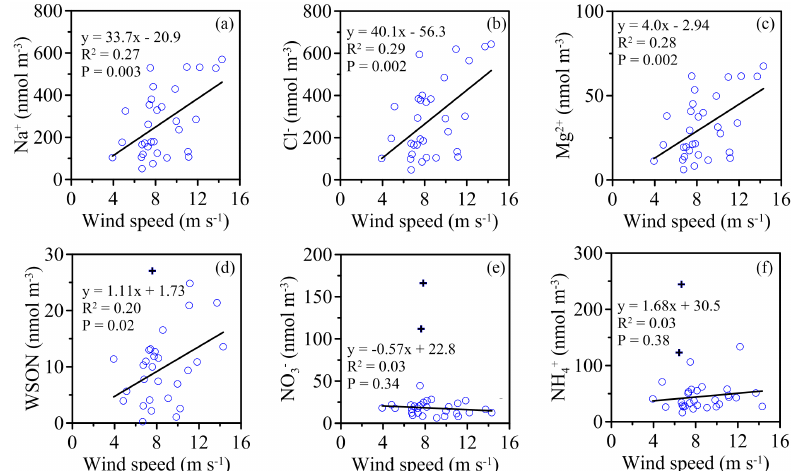
Figure 8. Scatter plots of concentrations of (a) Na + , (b) Cl − , (c) Mg 2 + , (d) WSON, (e) NO − speed for background aerosols. Wind speed was derived by averaging wind speed (5min average) in corresponding sampling intervals. Crosses in (d) , (e) and (f) were not considered during the linear